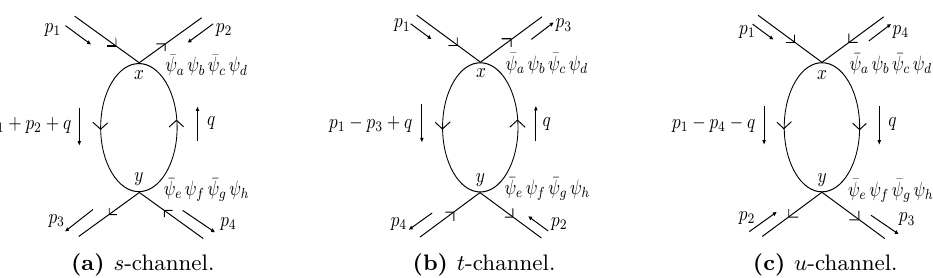
Figure 3 . The s , t and u -channels of a typical bubble diagram that contribute to the S -matrix at second